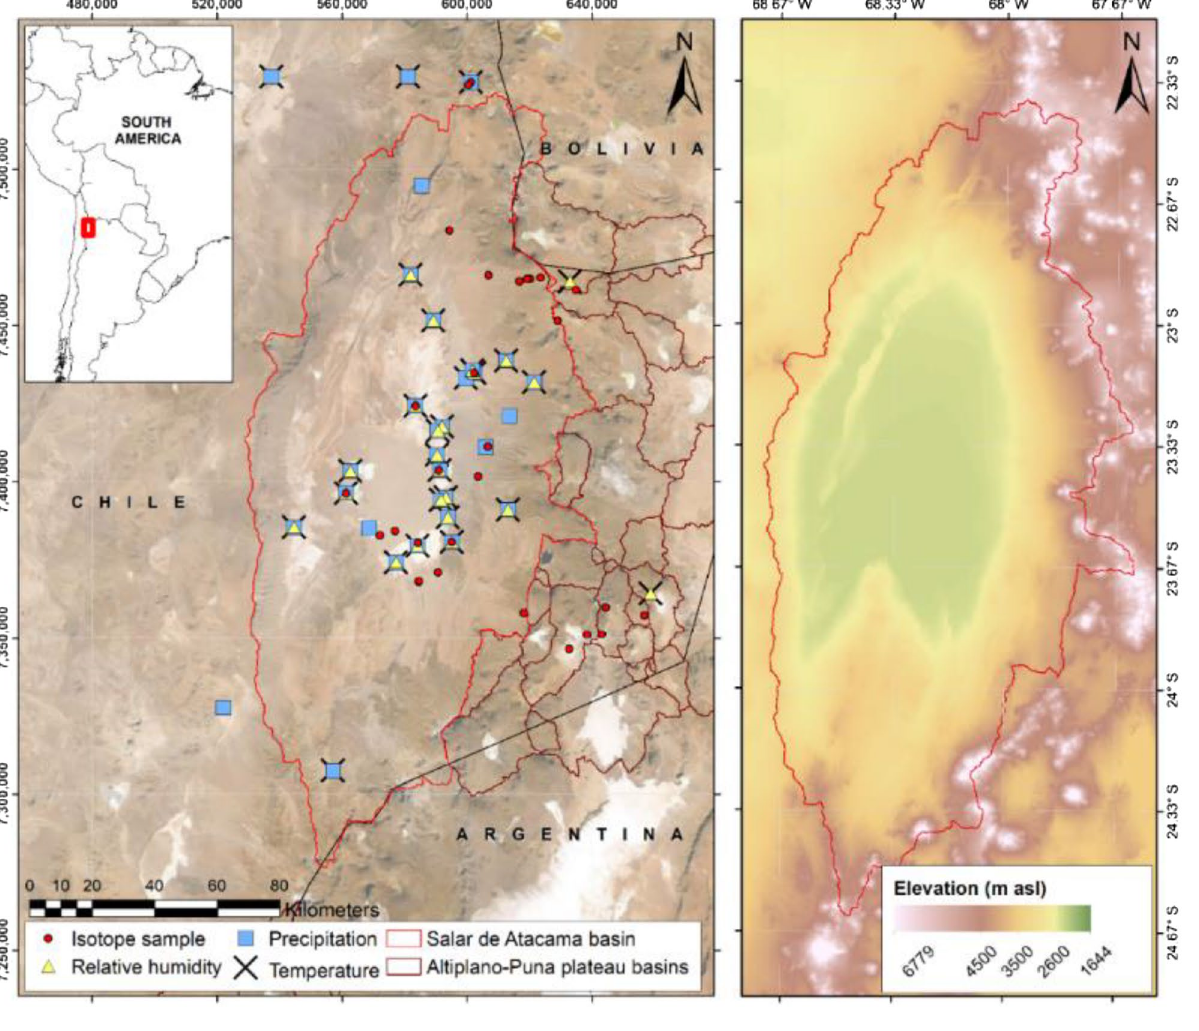
Figure 9. Left: location map of the study area in South America with published isotopic precipitation data (red circles) and automatic weather stations that monitor temperature (crosses), precipitation levels (blue squares) and relative humidity (yellow triangles). The solid red line delineates the Salar de Atacama basin, and the solid brown line shows the Altiplano-Puna plateau basins. The base map is derived from satellite data (SRTM from http:// earth explo rer. usgs. gov/). All location data are in UTM Zone 19 S coordinates based on the WGS of 1984. The utilized DEM is an ALOS PALSAR RTC product that has a resolution of 12.5 × 12.5 m and is provided by the Alaska Satellite Facility. Right: elevation map of the Salar de Atacama